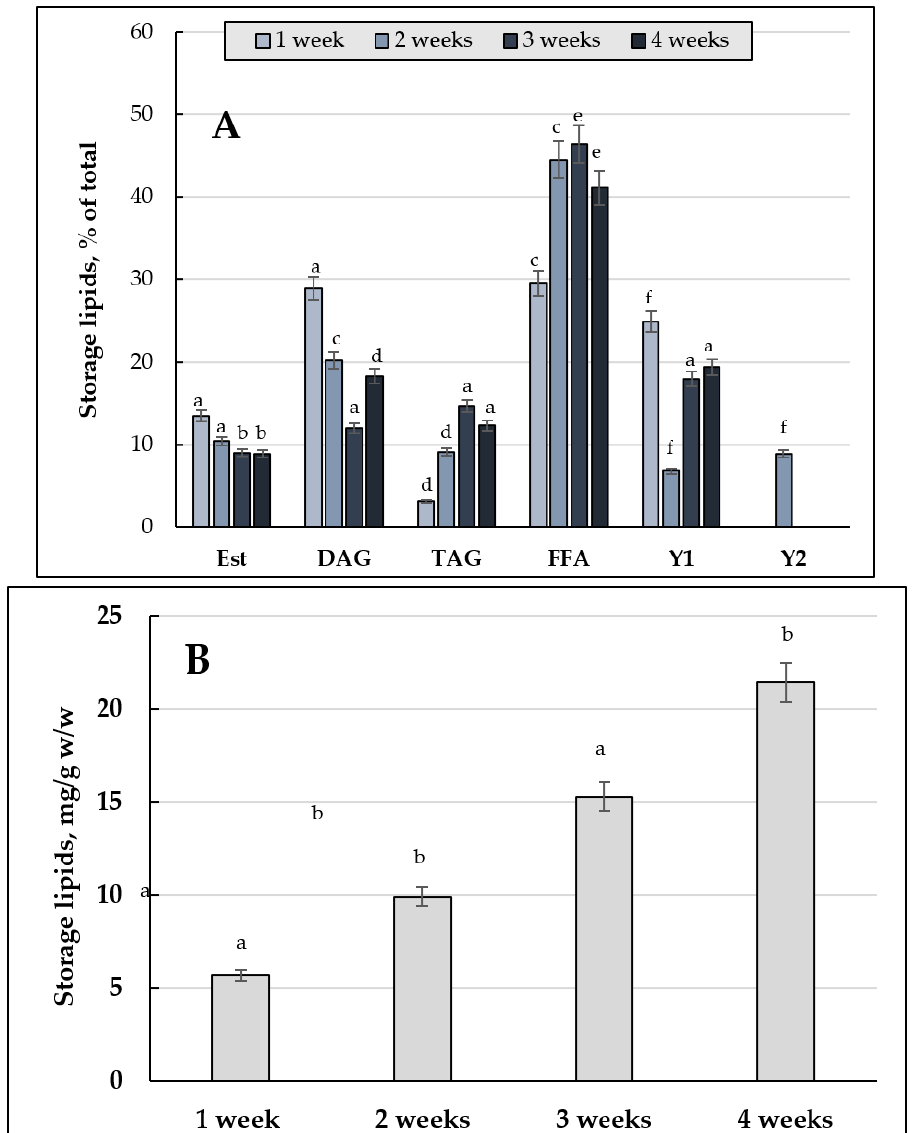
Figure 7. The storage lipid composition in E. magnusii yeast in the different growth phases during long-lasting cultivation under 0.2% glucose utilization. ( A ) the share of each storage lipid fraction, %; TAGs—triacylglycerols; DAGs—diacylglycerols; FFAs—free fatty acids; Est—sterol esters; Y1, Y2—unknown fractions ( B ) the share of each storage lipid fraction (μg/g). Values are mean ± S.E.M from three independent experiments and three analytical replicates. a— p < 0.04; b— p < 0.01; c— p < 0.001; d, e— p < 0.02; f— p < 0.002.